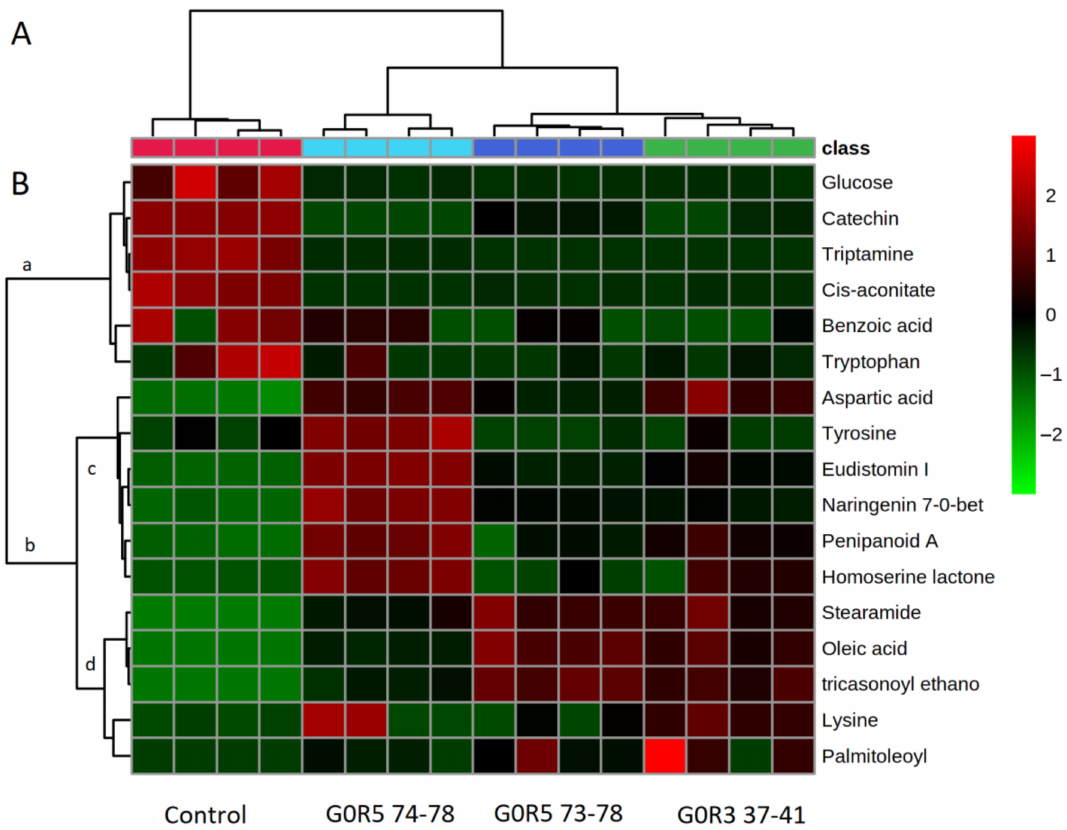
Figure 5. Dendrogram obtained after the hierarchical classification of metabolite profiles in the control and G. boninense–S. parasiticum co-culture fractions. ( A ) Heat map of metabolites are shown. ( B ) Bright red denotes highest intensities of metabolites, and light green denotes the lowest intensities or complete absence of